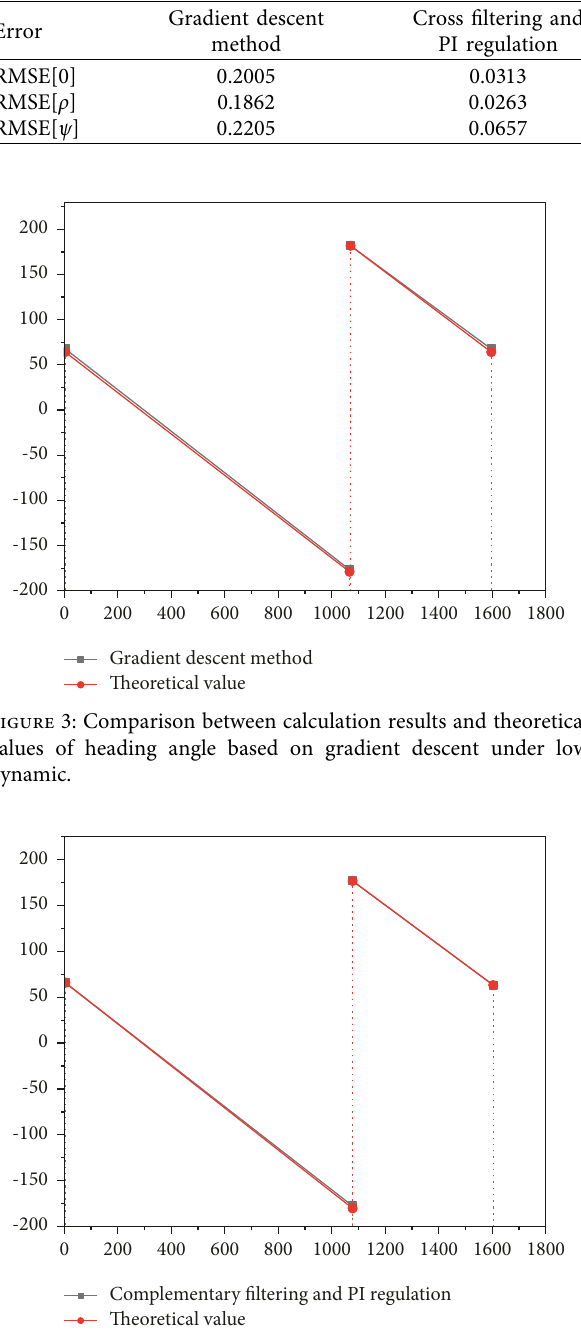
Figure 4: Comparison of course angle calculation results and theoretical values based on complementary filtering and PI ad- justment under low dynamic.